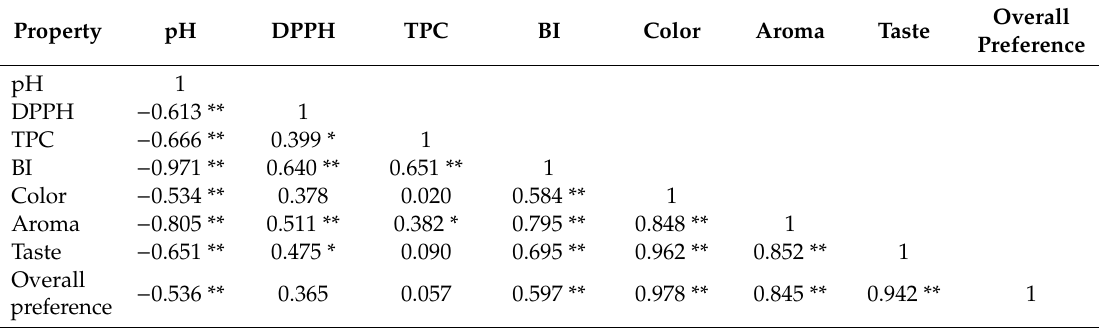
Table 5. Pearson’s correlation matrix of the antioxidative and quality characteristics of the brew. Property pH DPPH TPC Color Taste